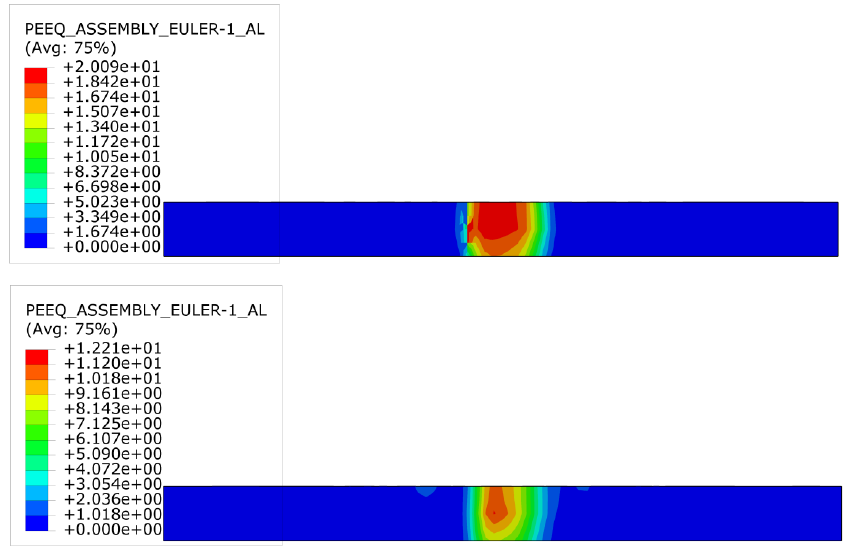
Figure 15. The equivalent plastic strain at the cross-sectional view of the welding.